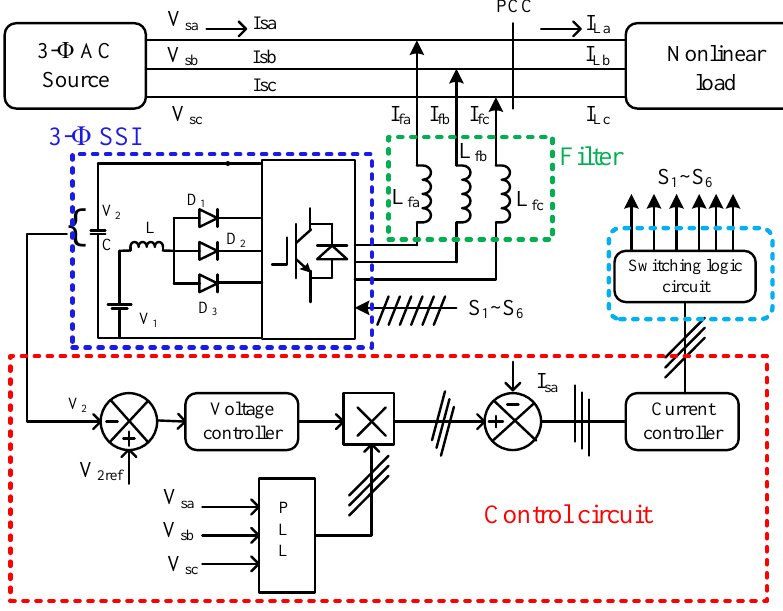
Figure 1. Block diagram of SSI-based SAPF for the three-phase, three-wire system.